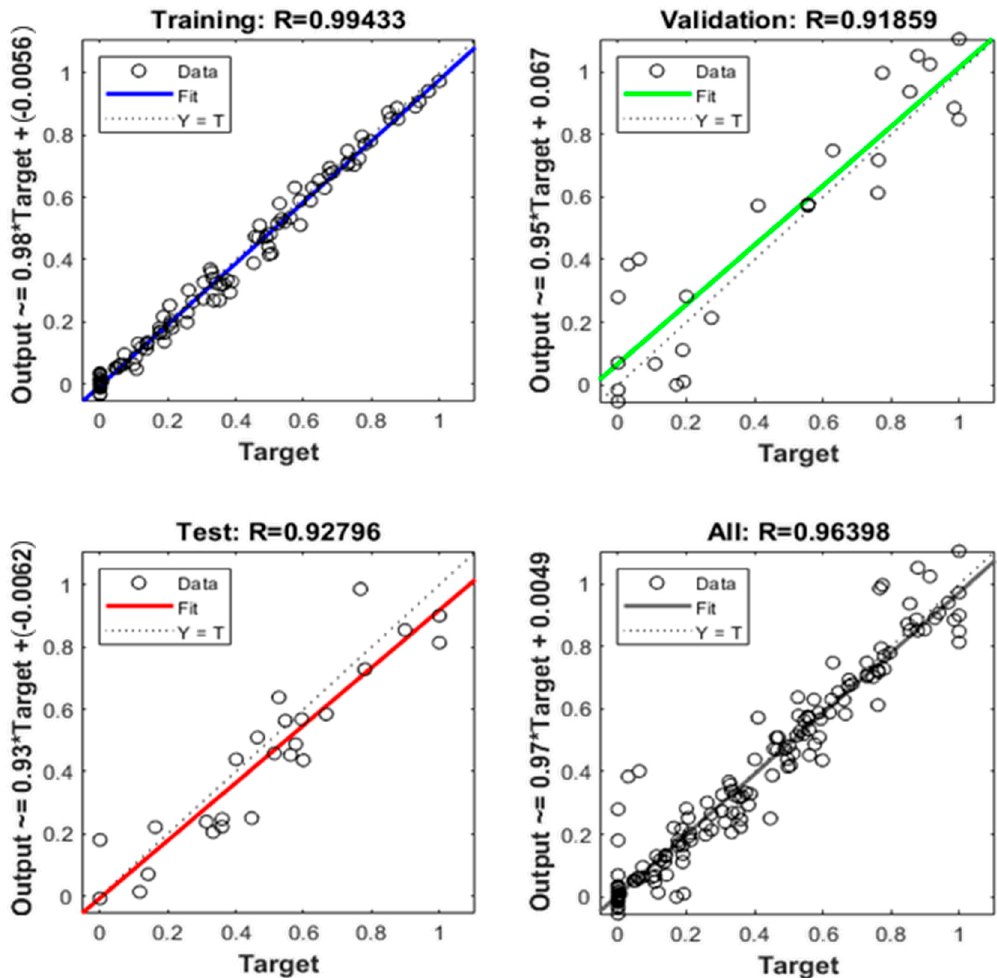
Figure 4. Neural network fitting accuracy (R).